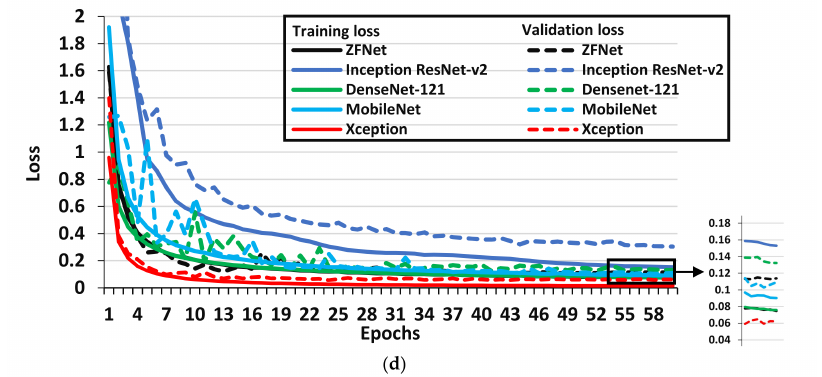
Figure 4. Performance plots of well-known CNN architectures. ( a ), ( b ) provide training and validation accuracy / loss of VGG-16, OverFeat, AlexNet, ResNet-50 and Inception-v4 architectures. ( c ), ( d ) provide training